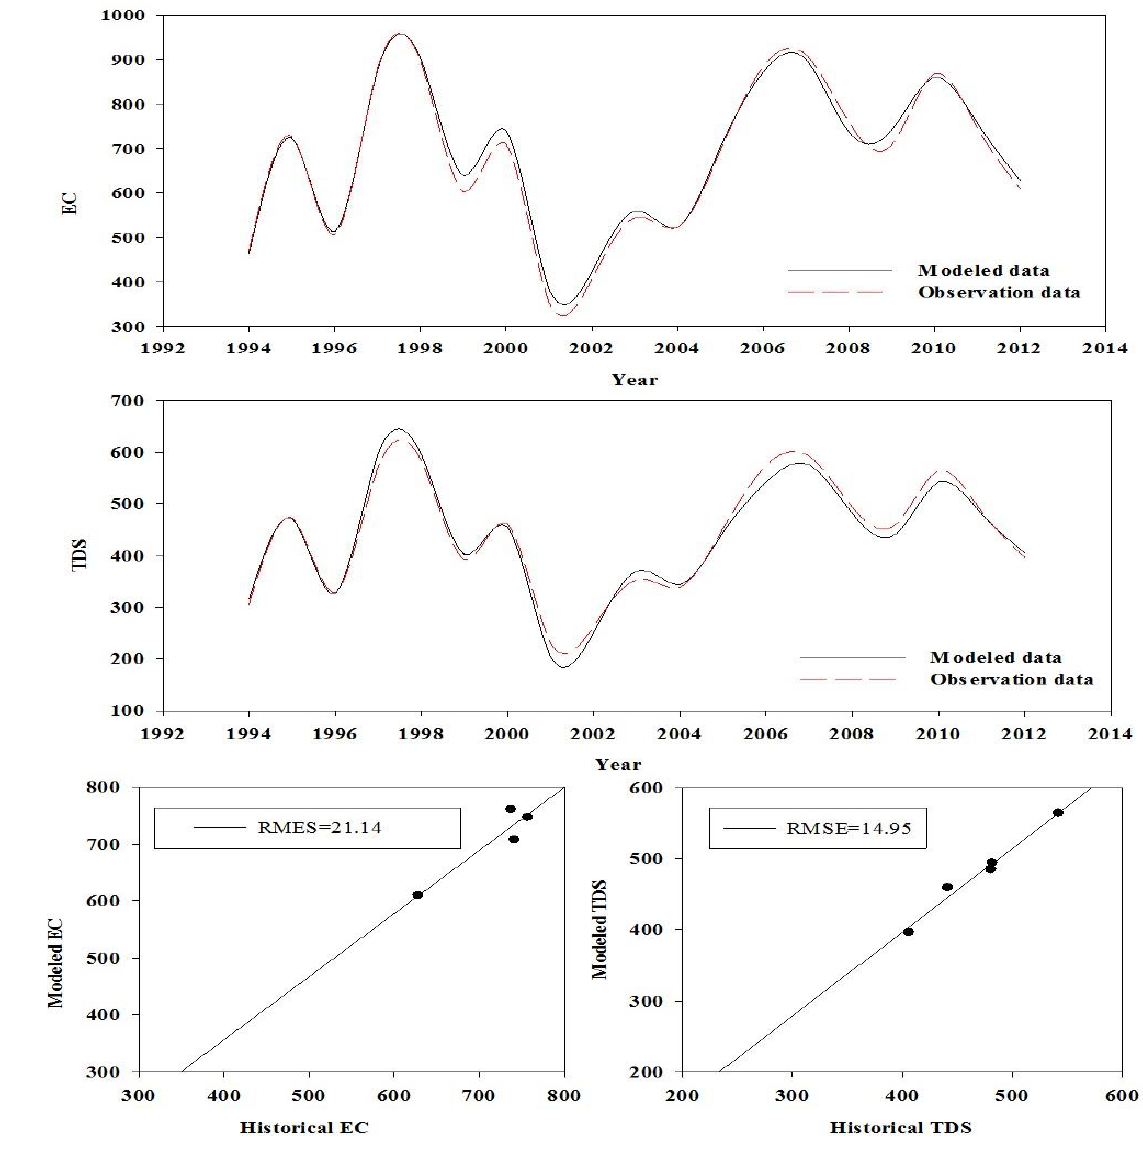
Fig. 2. The results of EC and TDS data modeling discussed in Gerd-e Yaghub